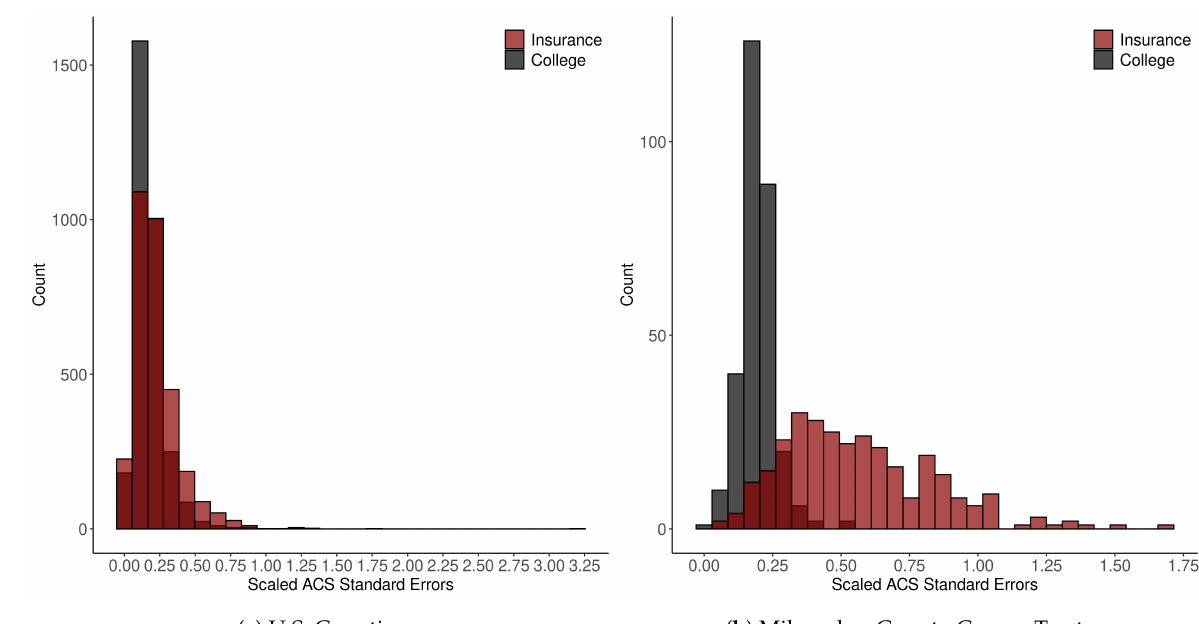
Figure 4. Histograms of scaled ACS SEs for percent insured and percent college educated. The values on the horizontal represent the ratio of each respective SE to the MAD of the variable of interest across its respective geographic domain (U.S. counties or Milwaukee County census